Question: Sum up the contents of this chart in one sentence.
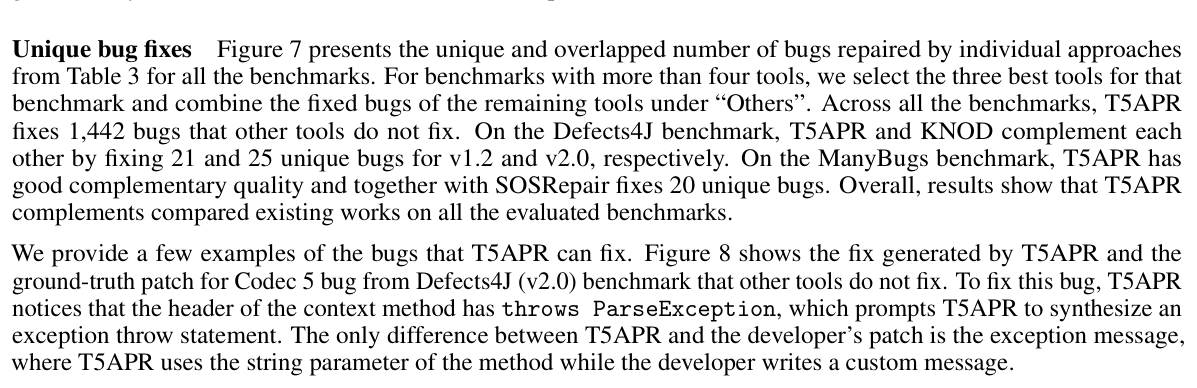
Answer: gives the T5APR patch for Bears-32, which is only fixed by T5APR. For this bug, T5APR adds a null check for the returned value of getStep(), which is a common pattern in Java. The developer’s patch for this bug is shown in Figure 3b. T5APR’s patch is semantically equivalent to the developer’s patch. Figure 10 shows another Bears